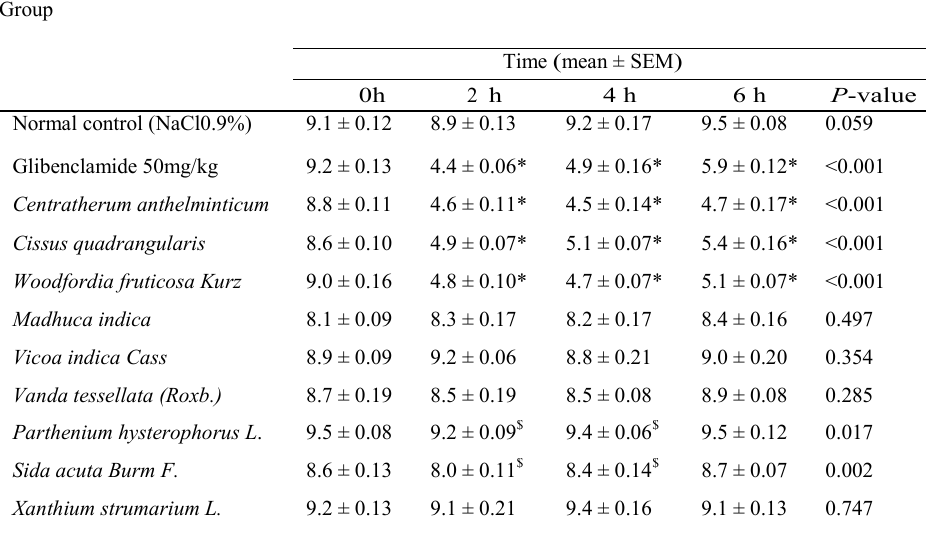
Table 3. Hypoglycemicactivityofleaf extract by oral route in normal rats. Blood glucose levels (mmol/L)at different time points (h) Group Time (mean ± SEM) 0h 2 h 4 h 6 h P -value Normal control (NaCl0.9%) 9.1 ± 0.12 8.9 ± 0.13 9.2 ± 0.17 9.5 ± 0.08 0.059 Glibenclamide 50mg/kg 9.2 ± 0.13 4.4 ±